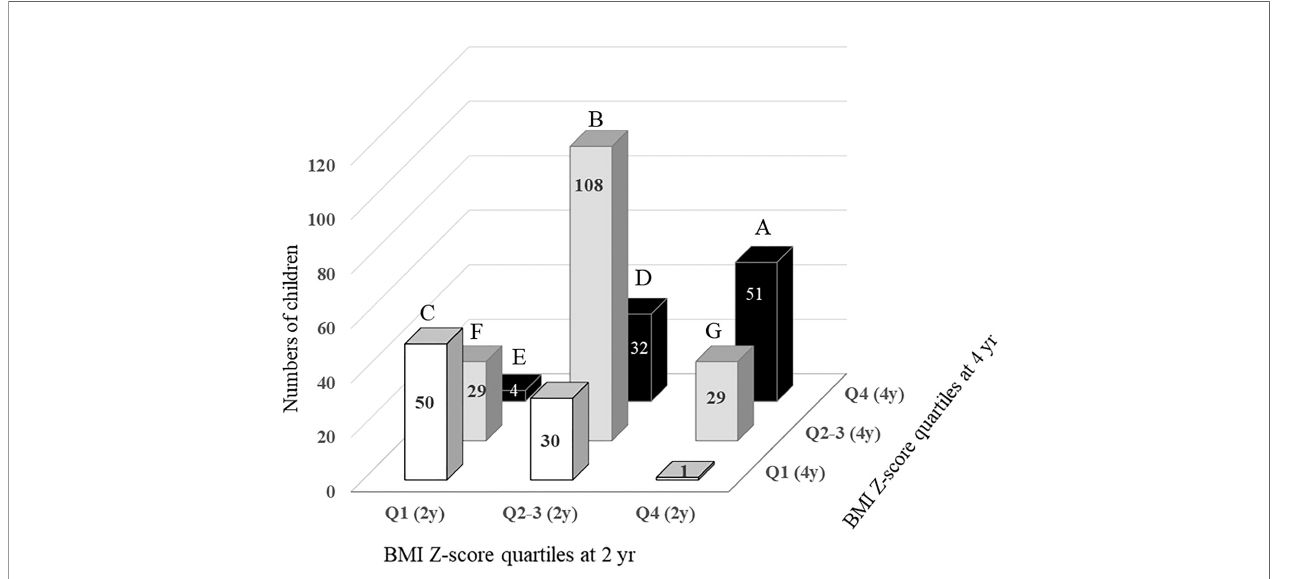
FIGURE 1 | Changes in BMI Z-score quartile in children between the ages of 2 and 4. A, children in Q4 at both ages 2 and 4. B, children in Q2-3 at both ages 2 and 4. C, children in Q1 at both ages 2 and 4. D, children with BMI Z-score quartile increasing from Q2-3 at age 2 to Q4 at age 4. E, children with BMI Z-score quartile increasing from Q1 at age 2 to Q4 at age 4. F, children with BMI Z-score quartile increasing from Q1 at age 2 to Q2-3 at age 4. G, children with BMI Z-score quartile decreasing from Q4 at age 2 to Q2-3 at age